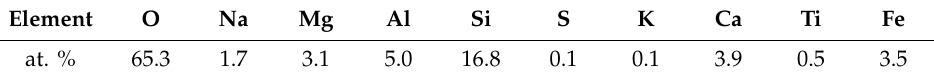
Table 1. EDS elemental analysis of the basalt mineral.